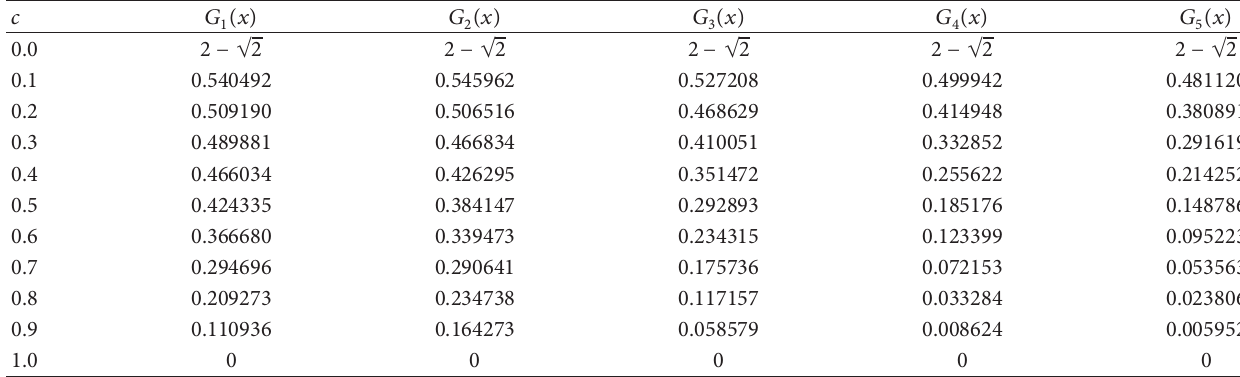
Table 1: The asymptotic optimal selection rates for various distributions and 𝑐